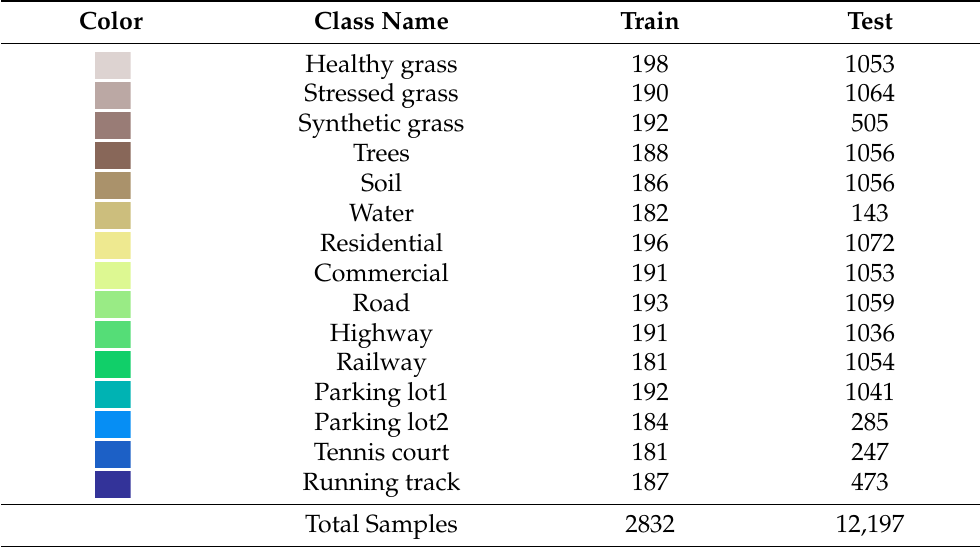
Table 3. The number of standard training and test samples in UH